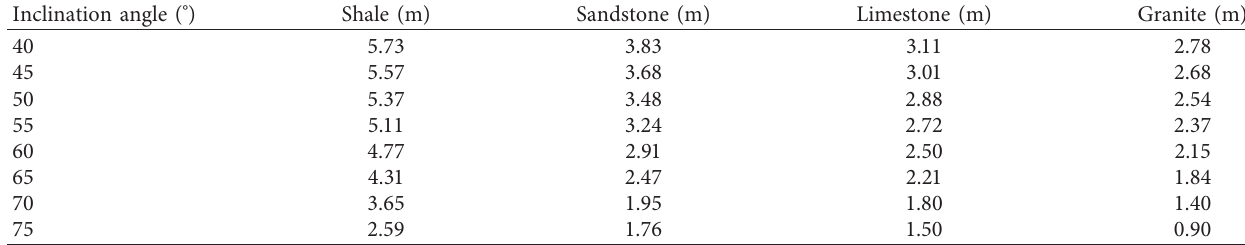
Table 2: The critical depth of the four types of rocks with auxiliary cut holes.